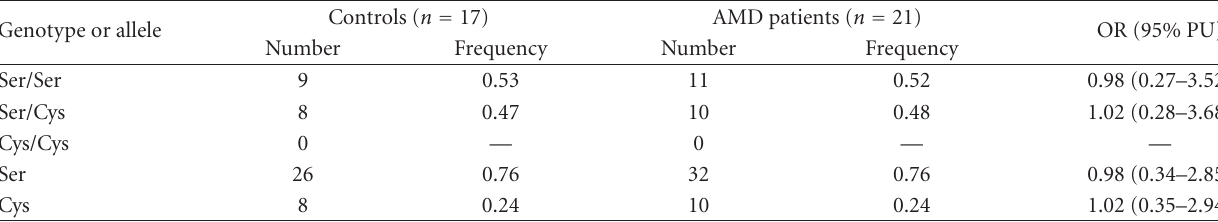
Table 3: The allele and genotype frequencies and odds ratio (OR) of the Ser326Cys polymorphism of the hOGG1 gene in AMD patients with ine ffi cient repair of DNA lesions induced by hydrogen peroxide. Ine ffi cient DNA repair occured when we did not observe a significant decrease in the extent of DNA damage after 120 minutes of repair